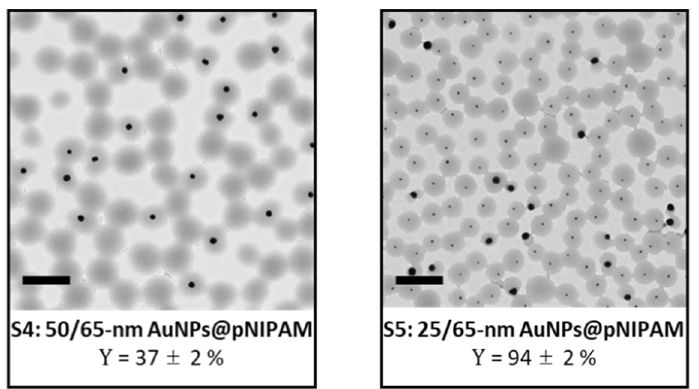
Figure 2 . Representative TEM images of both synthesized bimodal samples: ( Left ) S4: 50/65 nm AuNPs@pNIPAM and ( Right ) S5: 25/65 nm AuNPs@pNIPAM. Scale bars are 500 nm.